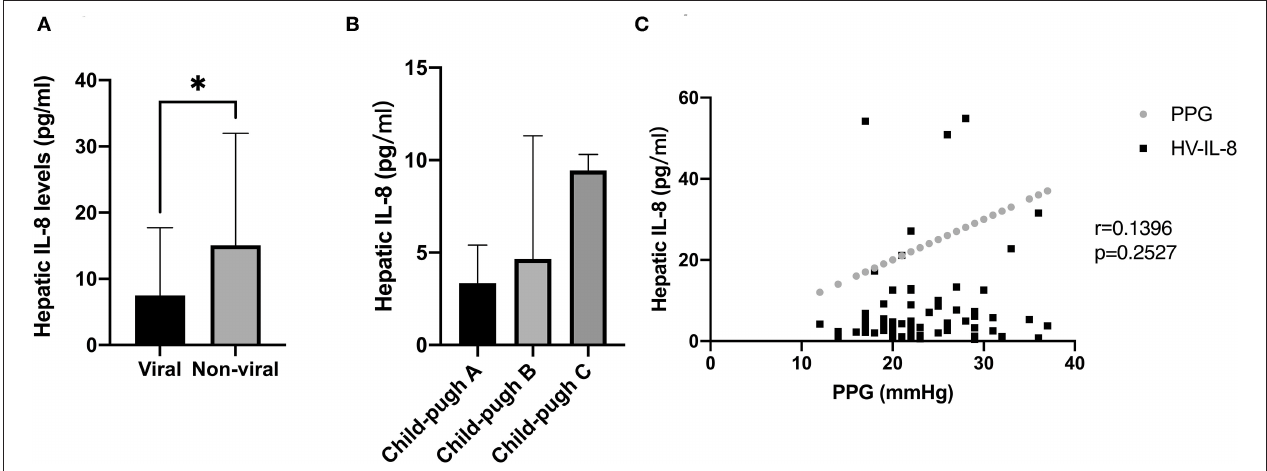
FIGURE 2 | Association between IL-8 level and the severity of cirrhosis, etiology of cirrhosis, and portal hypertension. (A) Patients with viral induced cirrhosis displayed lower hepatic IL-8 levels than patients with non-viral cirrhosis. (B) Patients with class B and C cirrhosis demonstrated higher levels of IL-8 in the hepatic veins than patients with class A cirrhosis. (C) There was no correlation between hepatic IL-8 level and PPG before the TIPS procedure. In (A,B) , data were shown as mean and SEM, and the Mann-Whitney test and Kruskal-Wallis test were used for unpaired comparison. In (C) , data were correlated by Spearman’s correlation analysis. * p <